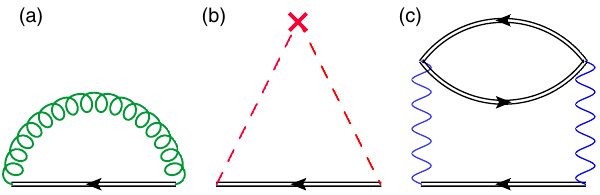
FIG. 1. Self-energies used in this study. (a) Electron-phonon self-energy in the Migdal approximation. (b) Impurity self-energy in the Born approximation. (c) Second-order electron-electron self-energy. All of these are treated self-consistently.